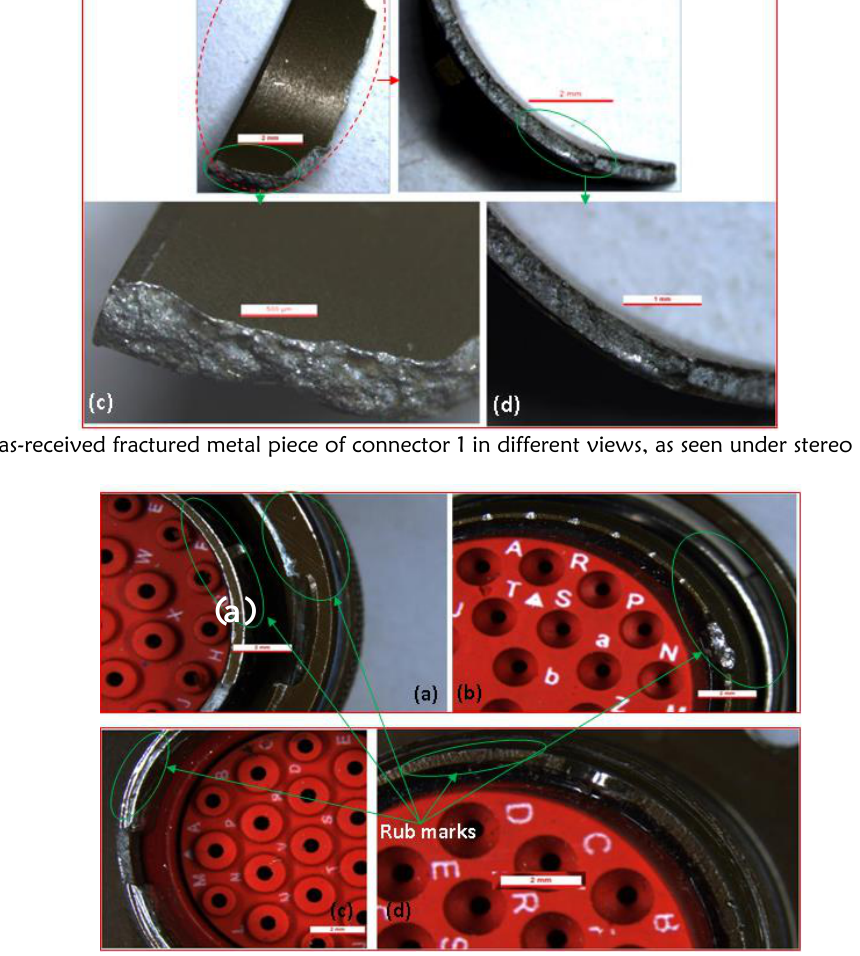
Figure 7: As-received connectors in different views, as seen under stereo microscope. (a, b) connector 1, (c, d) connector